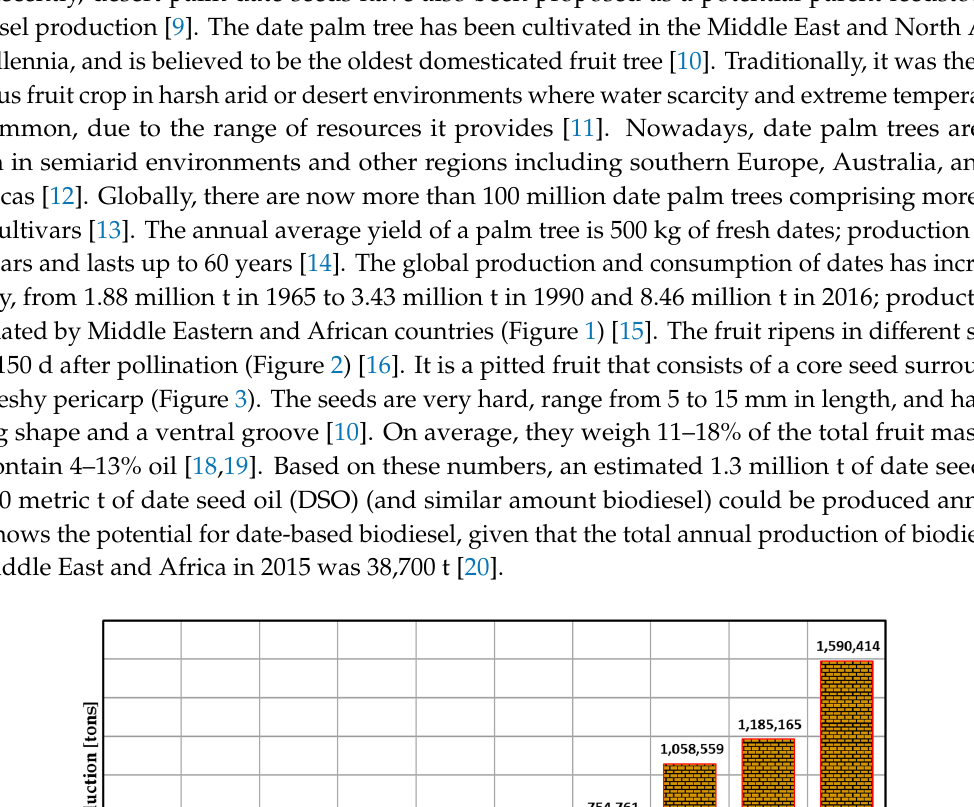
Figure 3. Date fruit and seed. Date seeds are a byproduct of fruit production that are often discarded as waste [21]. Traditionally, they were used as fodder for domestic poultry and other animals [22,23], and have also been turned into caffeine-free coffee in the Arabian Peninsula [24,25] or pharmaceutical and cosmetic products [26]. A few recent studies have proposed using DSO as a potential feedstock for biodiesel production [9,27,28], but these only investigated the production processes and assessed the effects of various parameters on oil extraction and biodiesel yield. In addition, it remains unclear whether the final fatty acid methyl ester (FAME) product matches standard biodiesel specifications as few DSO biodiesel properties have been compared with such standards [9,27]. Table 1 summarizes previously reported parameter values and highest DSO yields under those conditions. Table 2 summarizes the parameters and reaction conditions for optimized biodiesel production as reported in the literature. In this study, we investigated production factors that could optimize DSO extraction and biodiesel production and tested four DSO biodiesel blends in a compression ignition (CI) diesel engine to evaluate engine performance and tailpipe emissions. Table 1. Parameters for date seed oil (DSO) extraction using the Soxhlet method. Combination Identifier